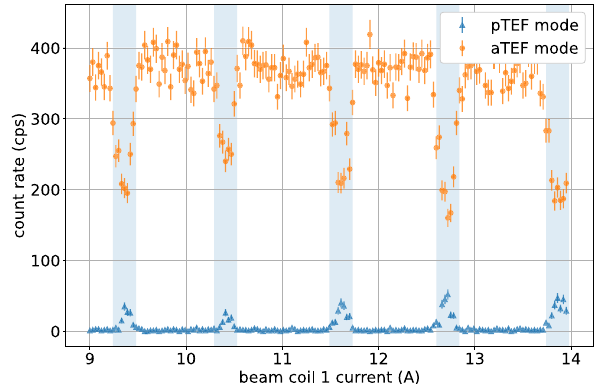
Fig. 5 Detected count rates as functions of beam coil 1 current when operating the transverse-energy filter in active mode (orange dots) or passive mode (blue